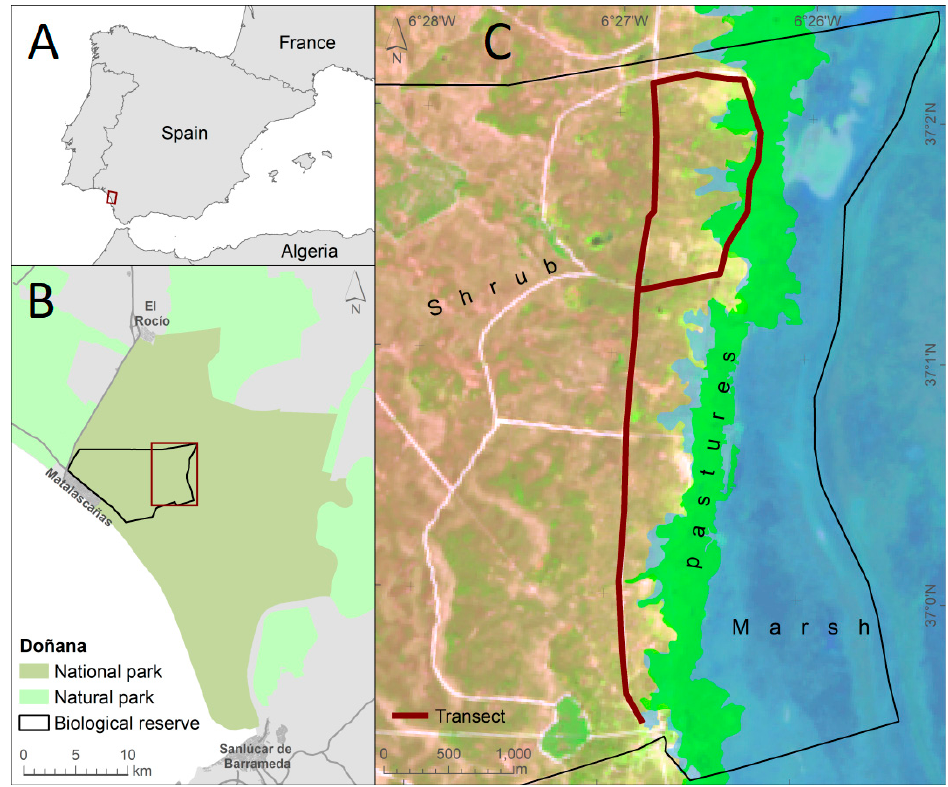
Figure 1. Location of the study area (Biological Reserve of Doñana) in Doñana National Park (( A , B ), southwest Spain). The transect (( C ), ~8 km long) used for roadside counts of lagomorphs.